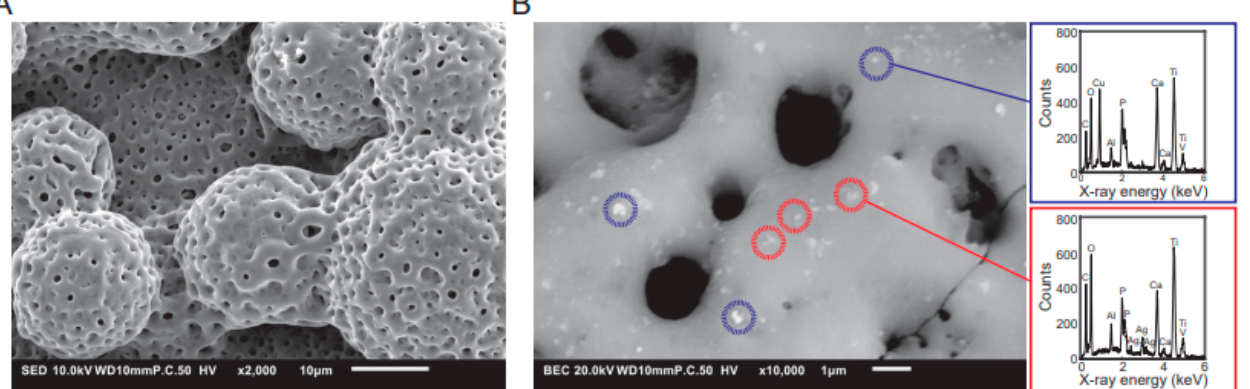
Figure 4. ( A ) SEM images of the typical surface morphology of titanium implants after PEO processing. ( B ) EDS analysis of the implant surface to characterize its chemical composition with spectrum of Cu (blue) and Ag (red) nanoparticles.